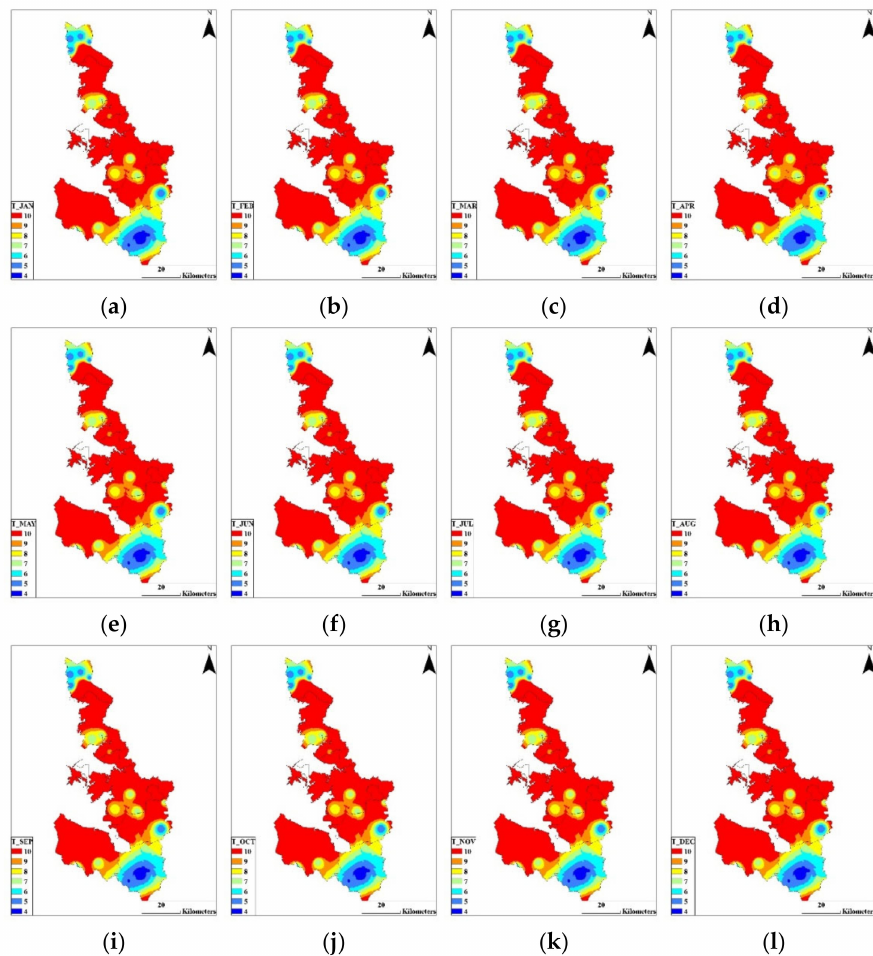
Figure 10. Thematic maps of the dynamic parameter rating for 10-year-averaged monthly saturated thickness of aquifer (T). ( a ) JAN; ( b ) FEB; ( c ) MAR; ( d ) APR;( e ) MAY;( f ) JUN; ( g ) JUL; ( h ) AUG; ( i ) SEP; ( j ) OCT; ( k ) NOV; ( l ) DEC.